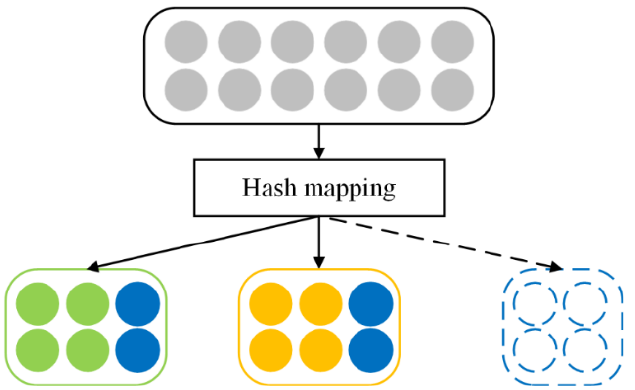
Figure 4. Initialization phase.